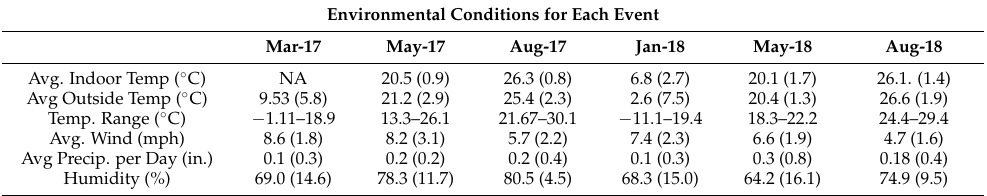
Table 1. Mean (Standard Deviation) environmental conditions monitored during each sampling event. Environmental Conditions for Each